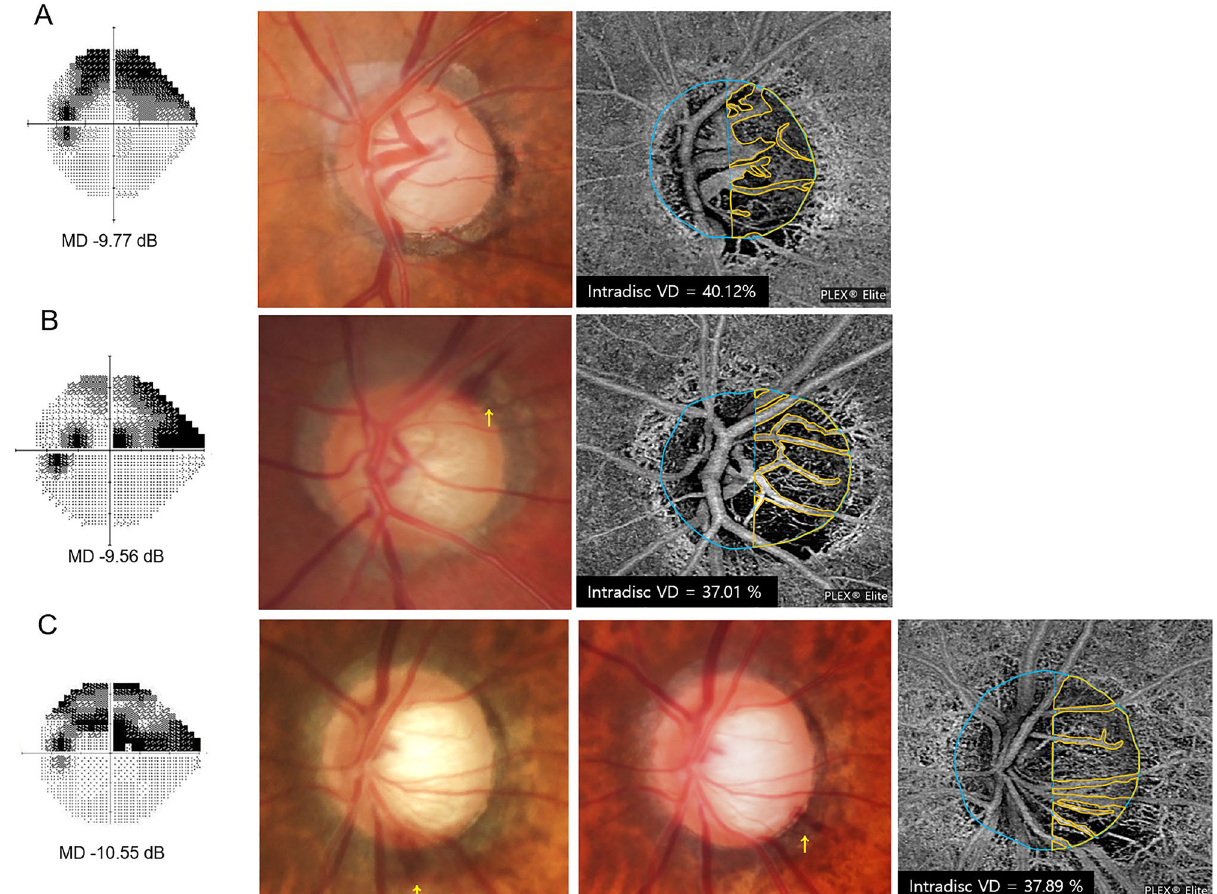
Figure 2. Representative primary open-angle glaucoma eyes with and without optic disc hemorrhage (ODH) . ( A ) A 65-year-old female patient without ODH during follow-up in her left eye. ( B ) A 64-year-old male patient with a single ODH in his left eye. ( C ) A 66-year-old male patient with recurrent ODH during follow-up in his left eye. All these eyes presented with choroidal microvascular dropout (CMvD) in the inferotemporal area and superior visual field (VF) loss with similar degrees of damage represented by VF mean deviation (MD). On an optical coherence tomography angiography (OCTA) whole-signal mode en-face image of the optic nerve head (ONH), the blue ellipse indicates the ONH margin and the blue vertical line denotes boundaries of vessel density (VD) measurement areas within the ONH passing across the optic disc center. The boundaries of the ONH (orange outline), excluding large retinal vessels, were manually demarcated. These areas of interest were used to measure the intradisc VD. The intradisc VDs were 37.01% and 37.89% in eyes with single ODH and recurrent ODH, respectively, which were lower than that in an eye without ODH